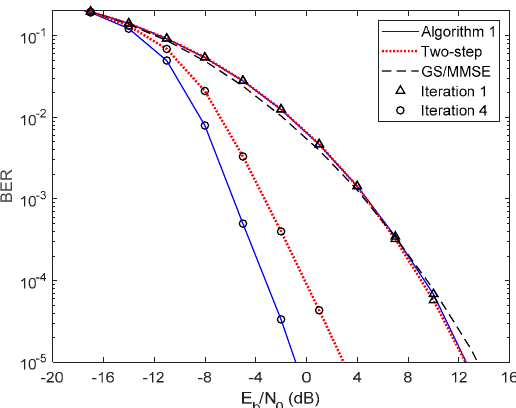
Figure 5. Performance comparison between the Algorithm 1, the two-step, and GS / MMSE approaches for the NCSI precoder with ULA configuration and QPSK modulation.